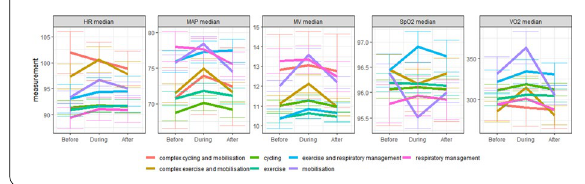
Fig. 1 Average trajectories of median physiological values with standard errors across the seven defined intervention types